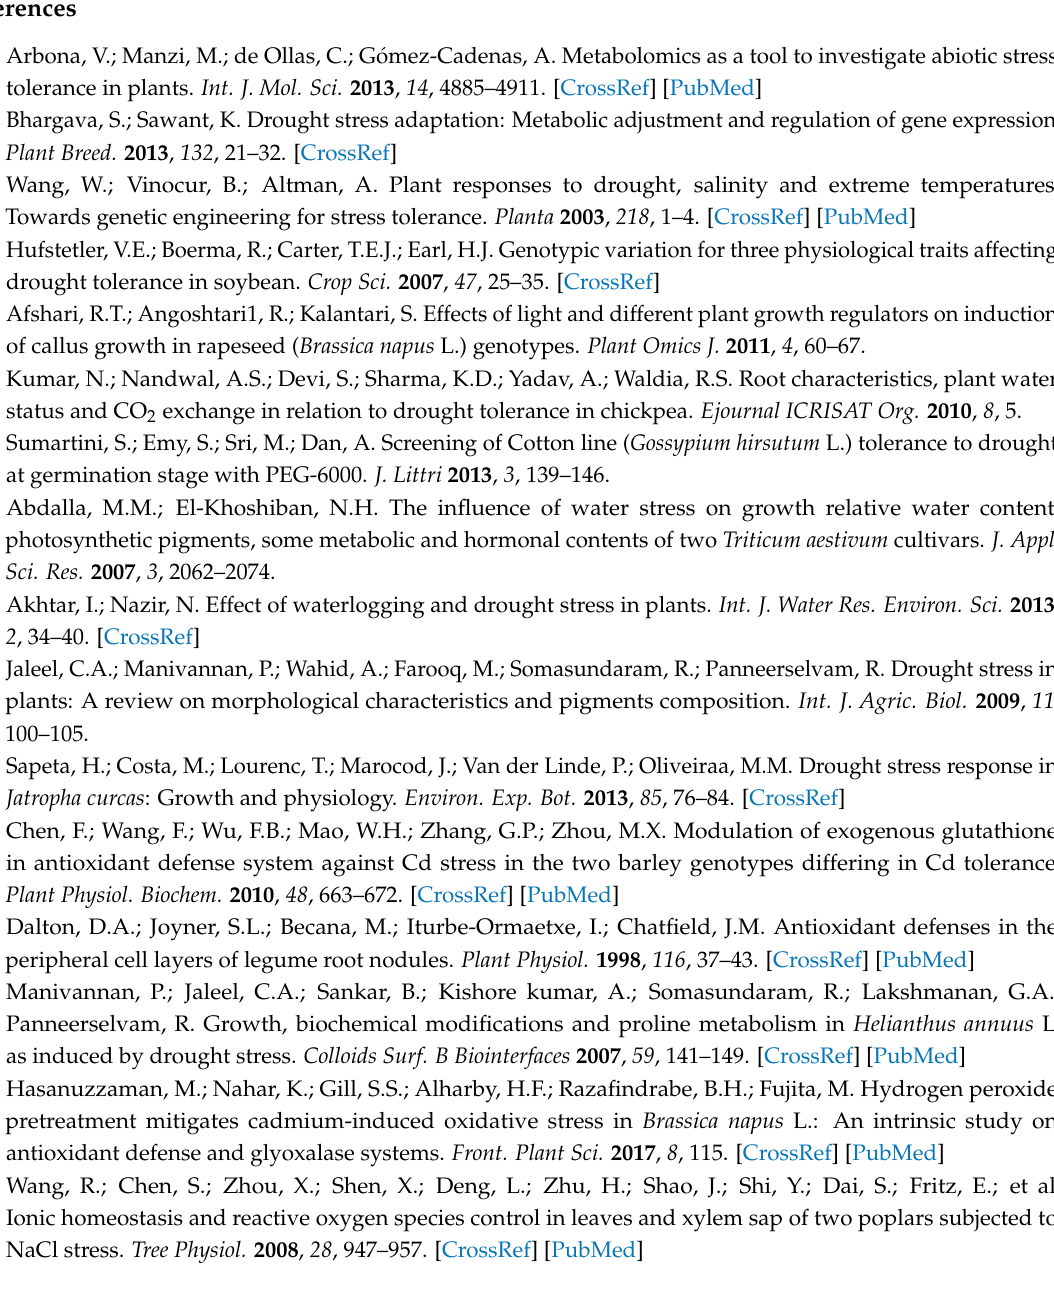
Figure S1: Effect of drought stress on fresh weight and dry weight of leaves, fresh weight and dry weight of stem, fresh weight and dry weight of root, in three-cotton species, Table S1: Na+, K+ and other mineral elements of three cotton species exposure to